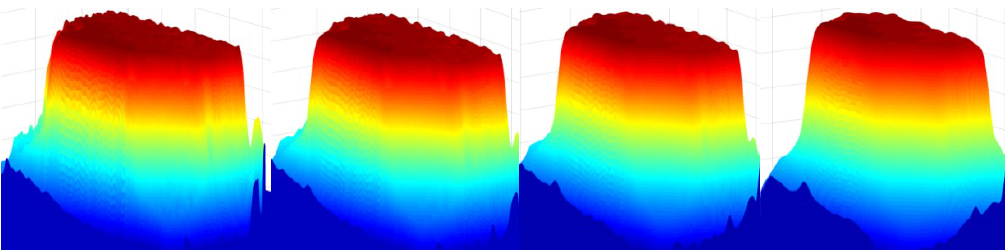
Figure 20. 3D topographic recovery map reconstructed by FSML focus evaluation operator using different evaluation windows.